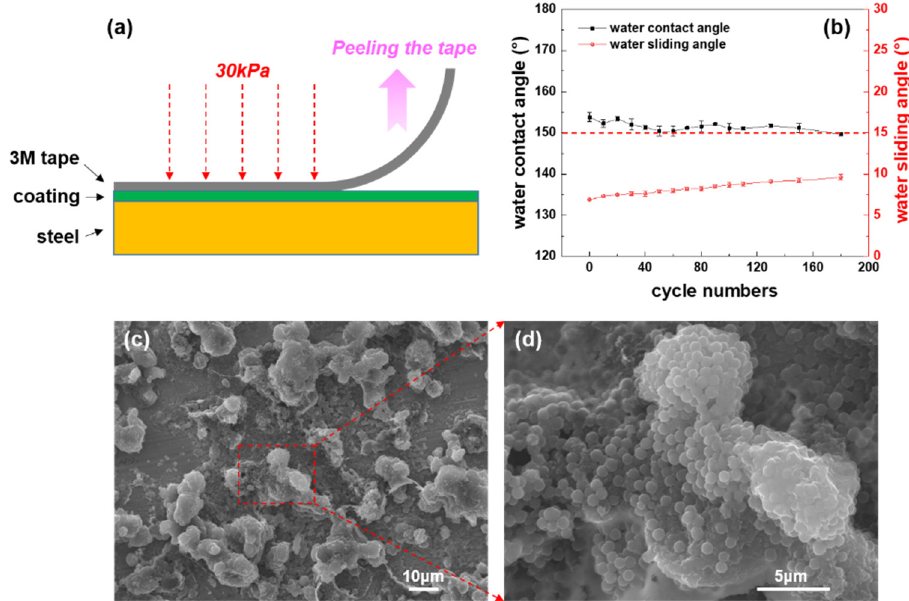
Figure 7. ( a ) The schematic of the tape-peel tests; ( b ) variation in the water contact angle and the sliding angle with peeling cycle numbers; ( c , d ) SEM images of the surface morphologies of the SNC after 180 tape-peeling cycles.